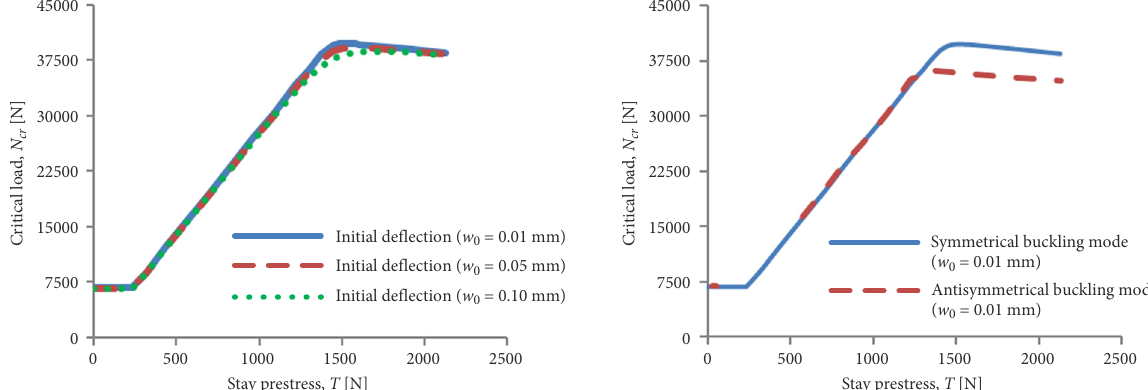
5. Critical load versus prestress (per one stay) for symmetrical buckling mode